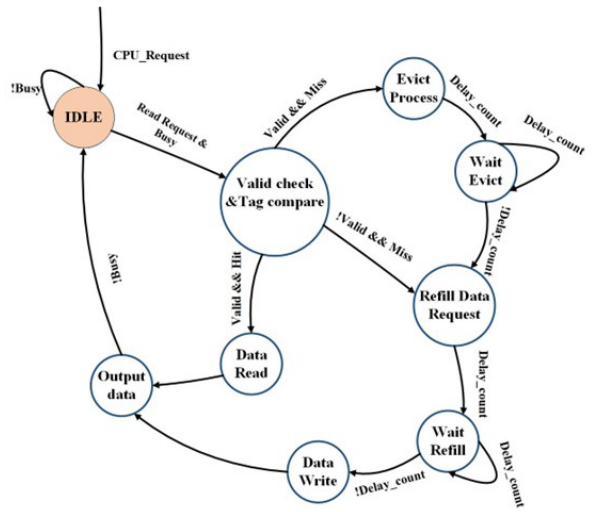
Figure 8. FSM of direct-mapped cache system for cache hit or